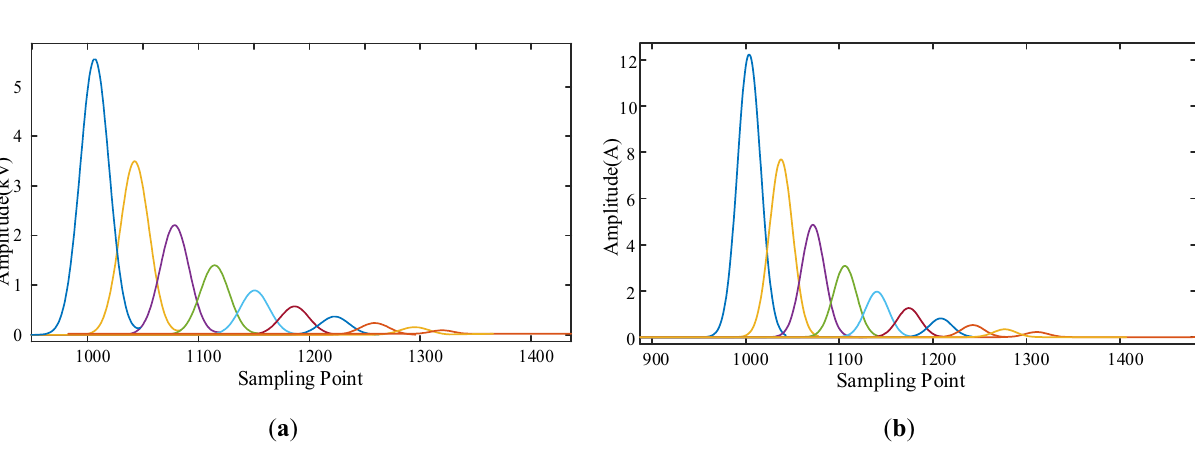
Figure 6. ( a ) S-transform results of voltage traveling wave at each measuring point; ( b ) S-transform results of current traveling wave at each measuring